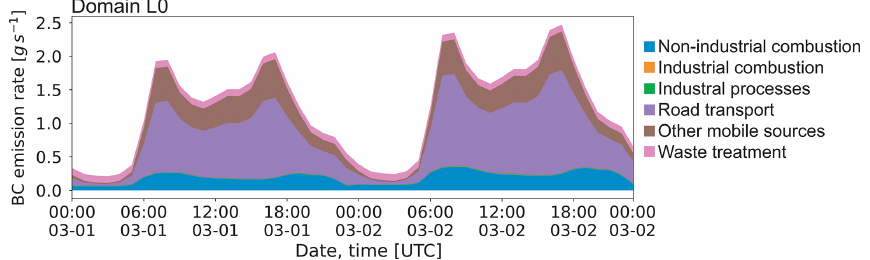
Figure 6. BC emission rate (TNO-MACC2 time profile) over simulation time accumulated over the domain L0 subdivided into the relevant SNAP